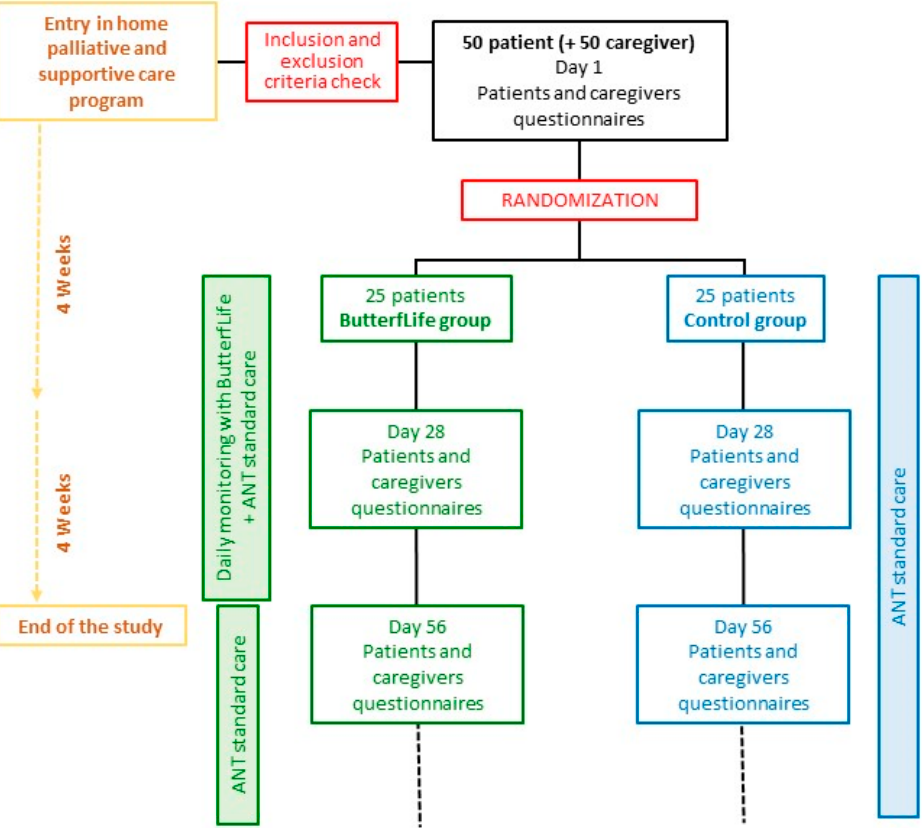
Figure 1. Flow diagram of the study. ANT: National Tumor Assistance Foundation.